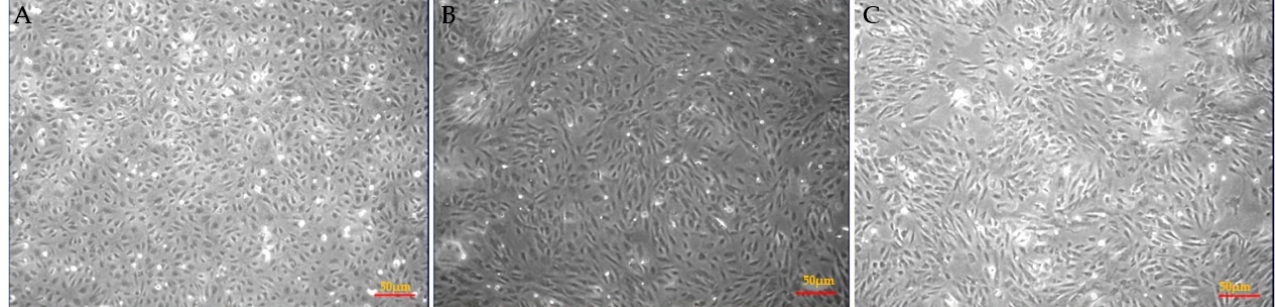
Figure 1. SAA-stimulates morphological changes in cultured HAEC. Representative images are shown for confluent HAEC treated with ( A ) DMSO (vehicle control) ( B ) 10 µg/mL SAA for 24 h, or ( C ) pre-treated with 25 µM 4-MetT for 24 h prior to addition of 10 µg/mL SAA and incubated further for 24 h. Data shown are representative of a single field of view, ( A – C ). Images were captured using an inverted light microscope with 10× magnification. Insets to panels ( A – C ) show higher magnification images of cells across the corresponding treatment groups.